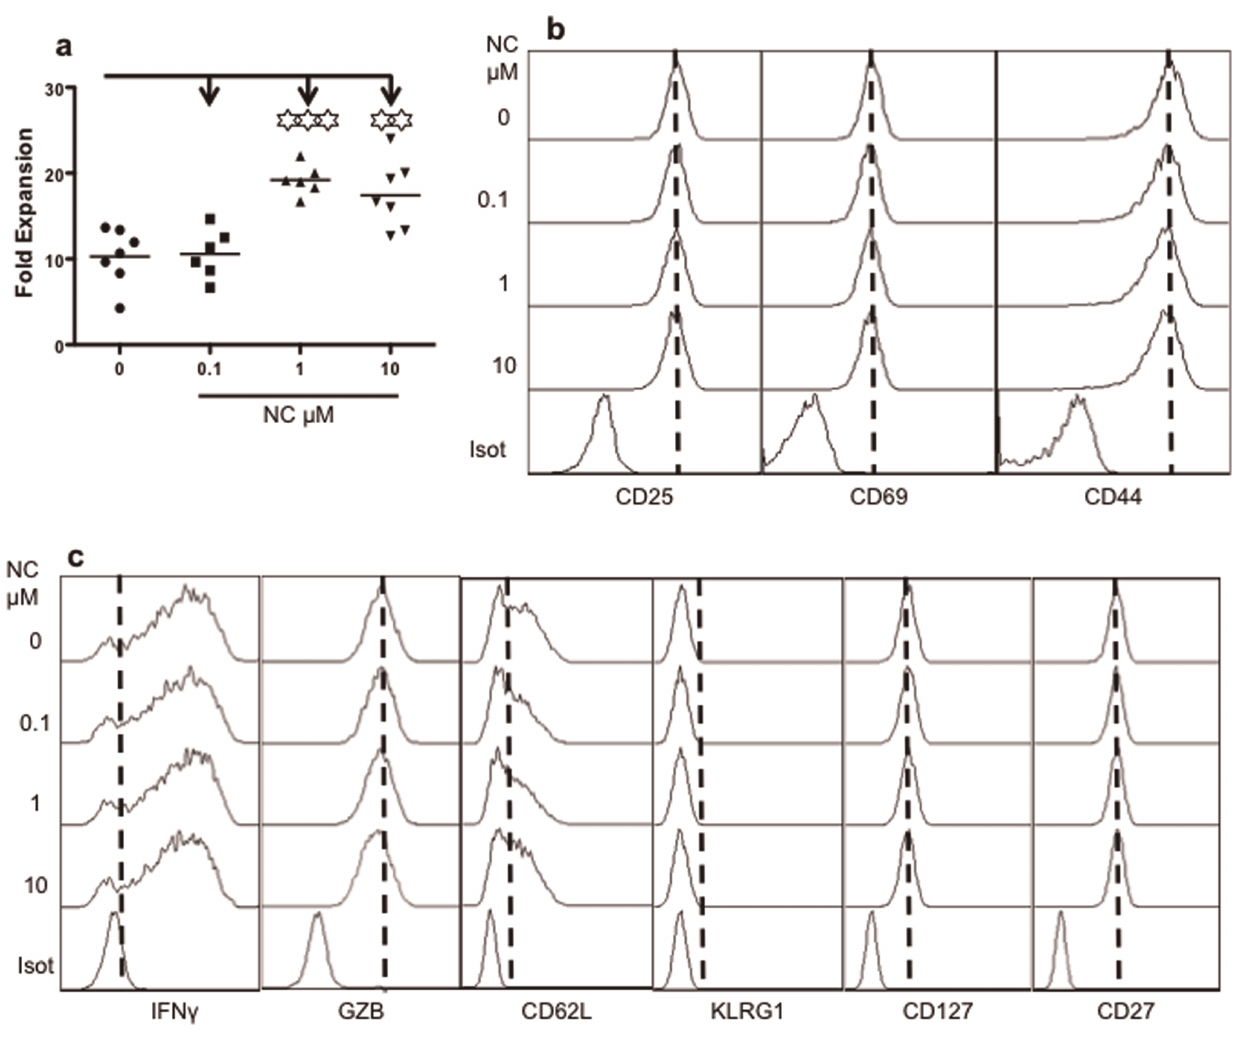
Figure 2. Nicotine does not affect CTL activation. Purified OT-I cells were cultured for 3 days with 3SI in the presence of nicotine at different concentrations. A. Comparison of fold expansion was calculated as the cell yield at day 3 divided by initial input cells at day 0. B. Cells were harvested to examine activation markers. C. Comparison of IFN c , granzyme B (GZB) and other surface molecules. Data are representatives of at least five experiments with similar results. Asterisks indicate statistical significance. *, P , 0.05; **, P , 0.01; ***, P , 0.001.